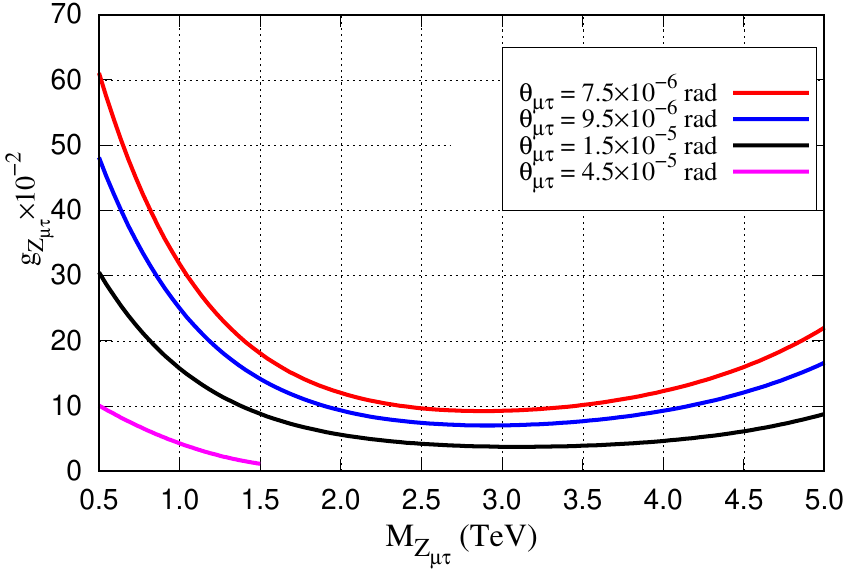
Figure 13 . Using the non-observation of a resonant ‘ + ‘ (cid:0) signal at the LHC running at 13 TeV, we have depicted the exclusion plots at 95% C.L. in the M Z of Z - Z (cid:22)(cid:28) mixing angle (cid:18) (cid:22)(cid:28) . The region above a particular curve has been ruled out from the non-observation of a resonant ‘ + ‘ (cid:0) signal in the 13 TeV run of LHC by latest ATLAS data [115] considering mass range [0.5, 5]